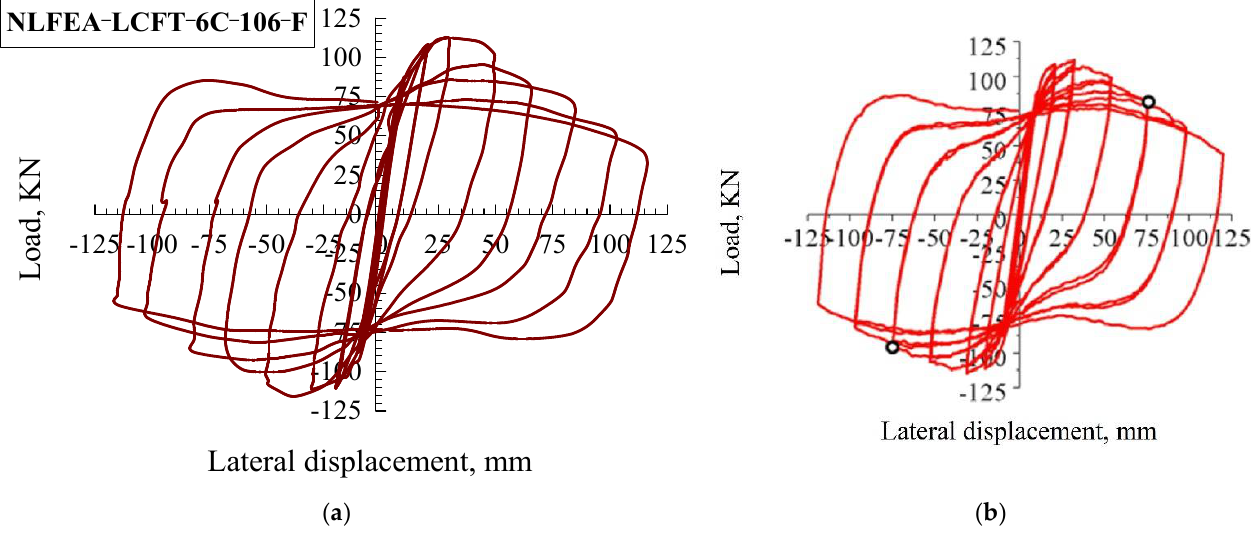
Figure 4. Validation of the results: ( a ) NLFEA and ( b ) reprinted from Yu et al. [32].